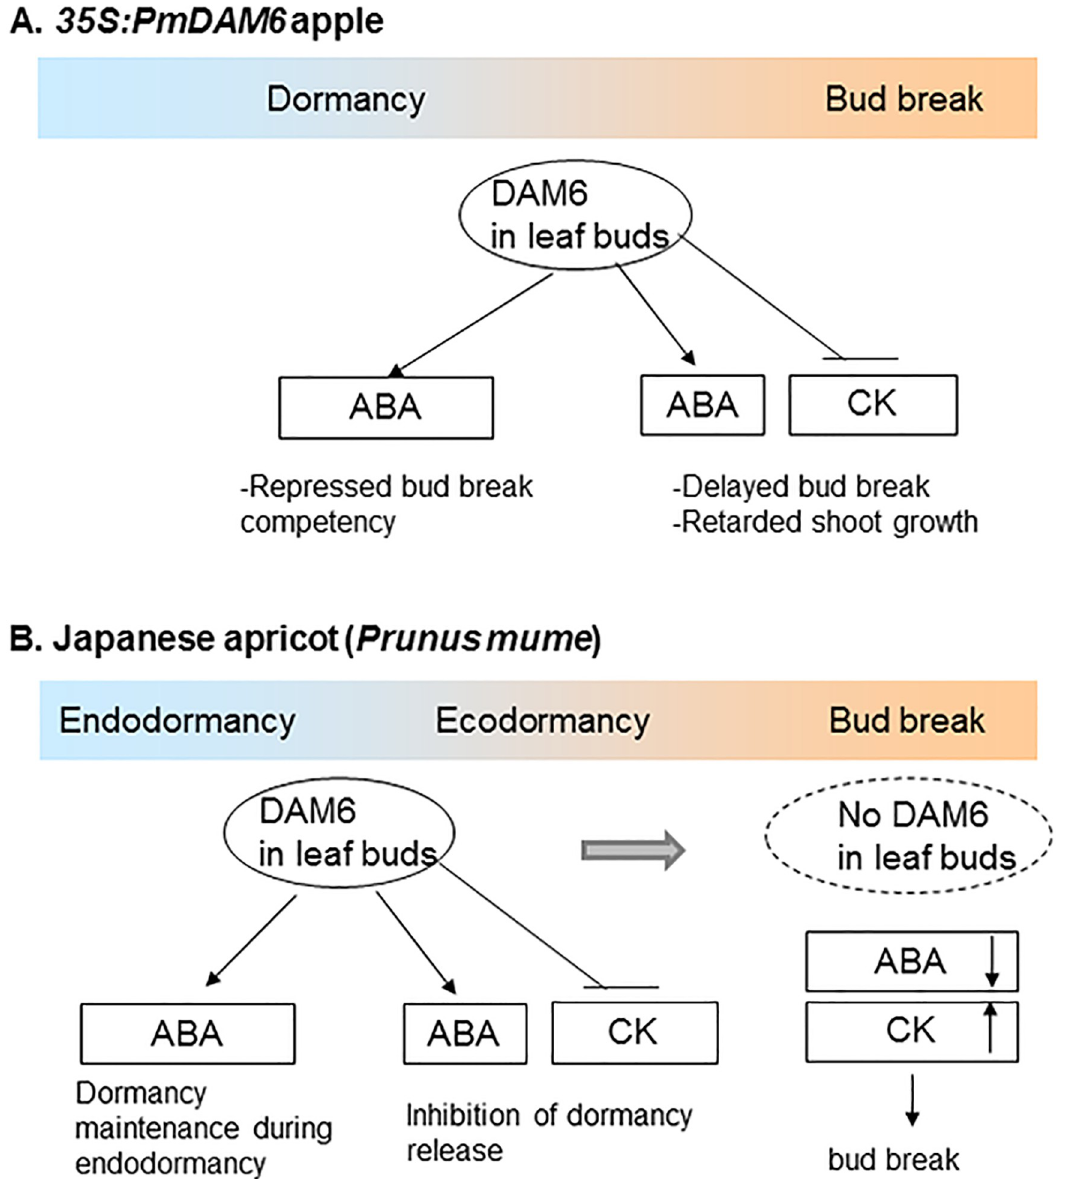
Fig 8. Schematic diagram of the proposed model of PmDAM6 functions during dormancy and bud outgrowth in PmDAM6 - overexpressing transgenic apple plants and in Japanese apricot. (A) Proposed model of PmDAM6 functions in 35S : PmDAM6 apple plants. PmDAM6 induces the accumulation of ABA and inhibits the accumulation of cytokinins (CK) in dormant terminal buds, which represses bud break competency and inhibited bud outgrowth. (B) Model of PmDAM6 -mediated dormancy regulation in Japanese apricot based on data obtained from transgenic apple plants (this study), seasonal changes in PmDAM6 expression levels [15, 19] and seasonal changes in phytohormone contents (this study) in Japanese apricot leaf buds. The expression of PmDAM6 is up-regulated during endodormancy and down-regulated during the endo- and ecodormancy release stages. Additionally, PmDAM6 expression is undetectable during bud break [15, 19]. Down-regulated PmDAM6 expression coincides with a decrease in ABA during the endo- and ecodormancy release stages and with an increase in CK levels during the ecodormancy release and bud break stages. We hypothesize that PmDAM6 maintains endodormancy by repressing bud break competency and increasing ABA levels and inhibits dormancy release by increasing ABA and decreasing CKs contents in dormant Japanese apricot buds.